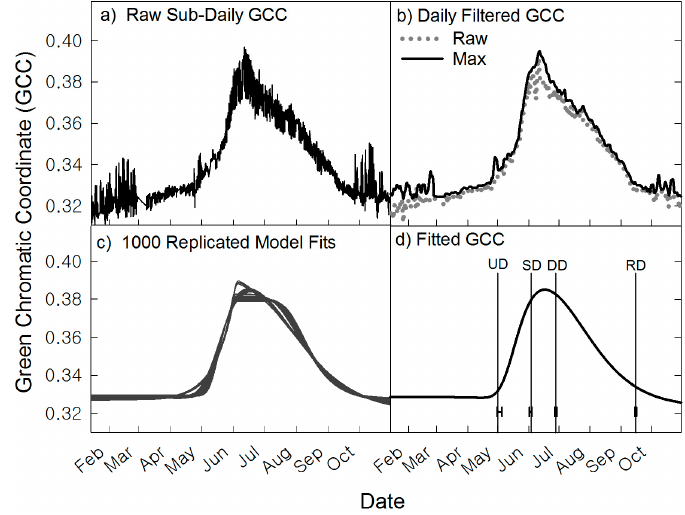
Figure 2. An example from the wet meadow of processing raw RGB values. ( a ) Raw GCC values acquired from extracting the per-pixel RGB digital numbers averaged across the ROI; ( b ) Three filters were applied in the order: night, spline, max . Max filtered GCC values calculated from sub-daily data after night and spline filters are applied. Raw GCC values at daily time steps are also shown as gray dots; ( c ) Filtered data fitted with uniform distribution of residuals around the observed data points to estimate uncertainty (1000 replications, gray lines); ( d ) The fitted line and median phenophase dates (vertical lines) upturn date (UD), stabilization date (SD), downturn date (DD) and recession date (RD) and the 10th to 90th confidence intervals around those dates.